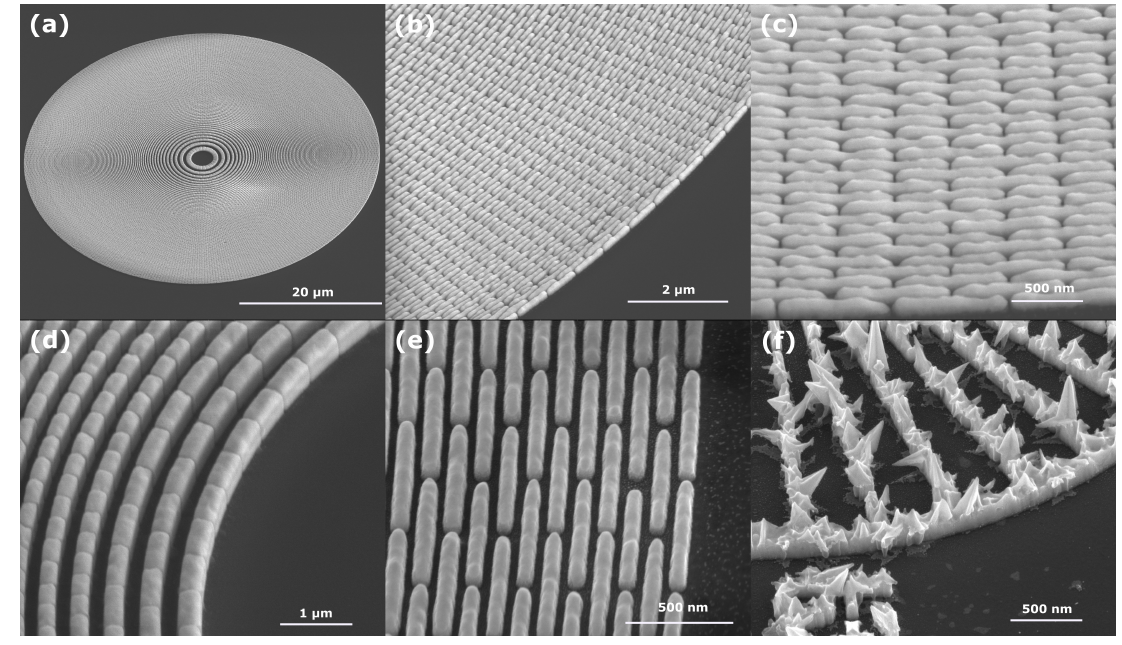
Figure 4. SEM micrographs of electroplated structures. ( a ) Overview of a zone plate with 50 nm outermost zone width. ( b , c ) Details of the outermost 50 nm zones. Plating height is approximately 280 nm. ( d ) Innermost zones of a 60 nm zone plate, plating height nearly 450 nm. ( e ) 60 nm outermost zones. ( f ) Siemens star structure electroplated without the Sb-brightener. Distinct growth of crystalline structures throughout the pattern can be